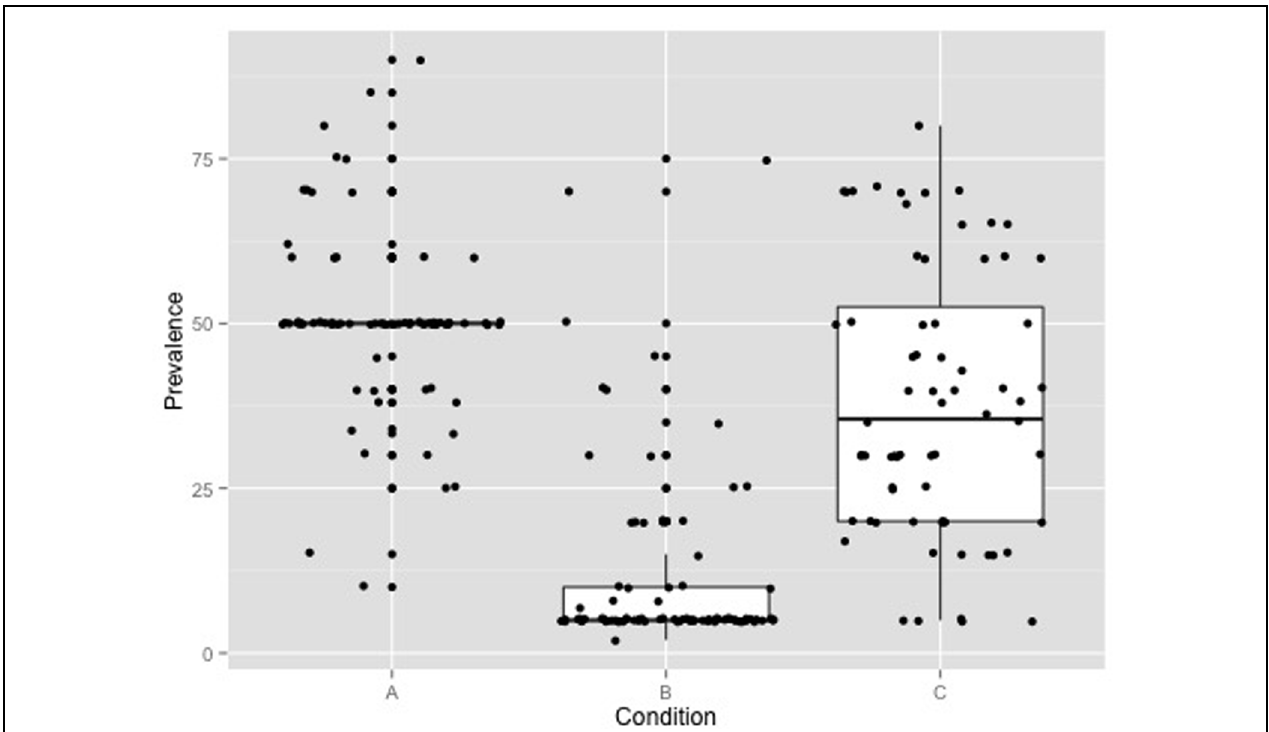
FIGURE 1 | Raw data and boxplots for participants’ answers to the question in manipulation check 1 (“According to recent research what percentage of university students in Germany have used caffeine pills at least once to enhance their performance and improve their learning?”) in experimental conditions A (50% peer prevalence), B (5%), and C (no information on peer